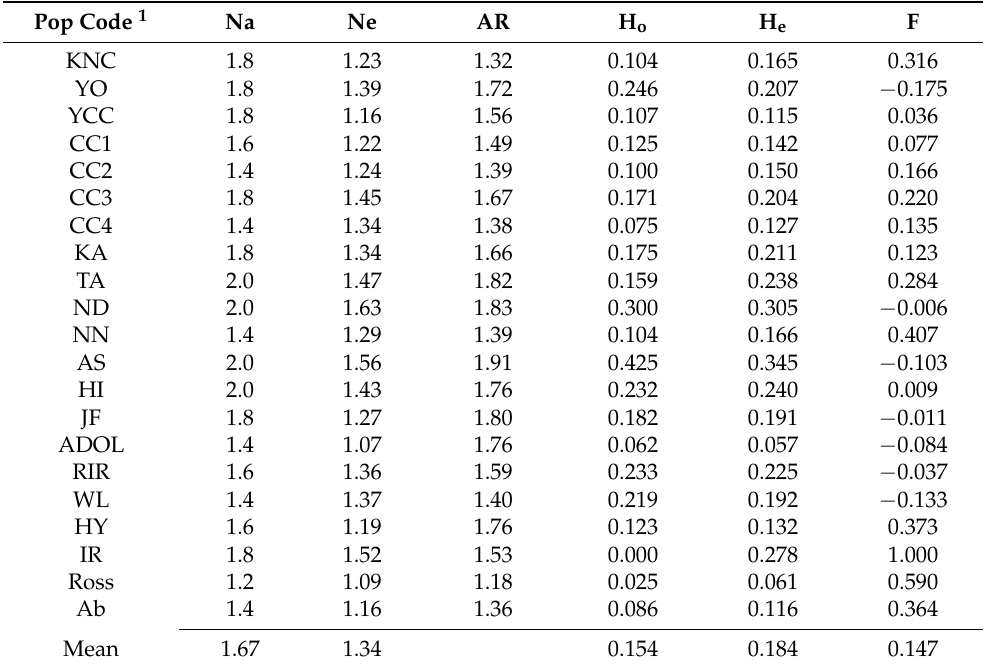
Table 2. Mean allele number, allele richness, observed and expected heterozygosity values for Set 1 microsatellite markers in 21